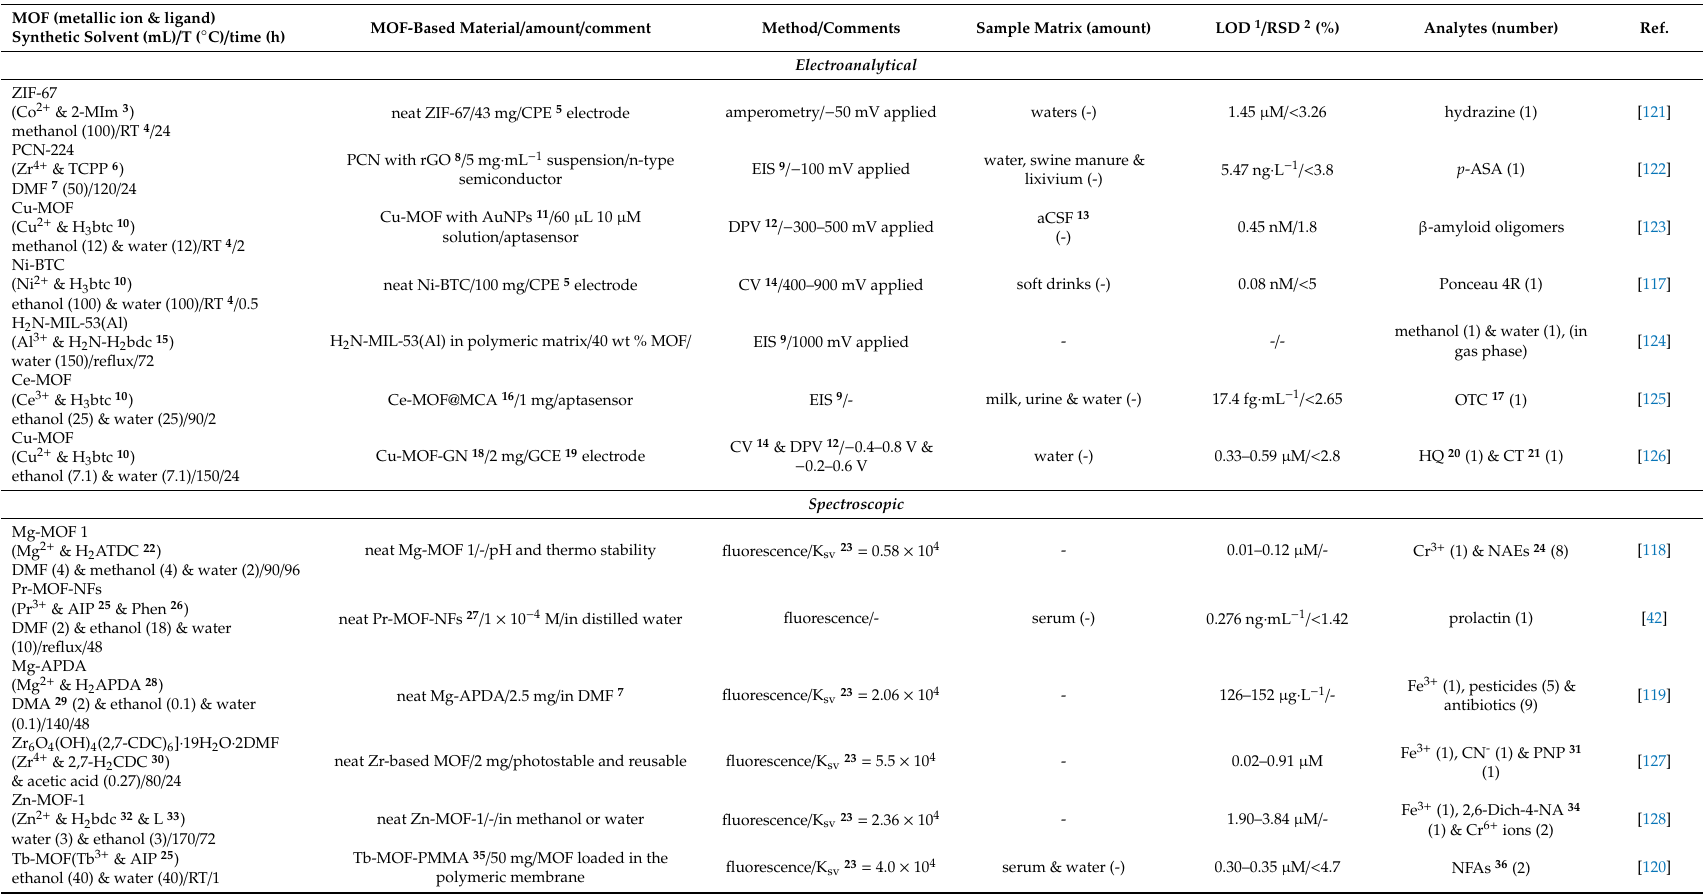
Table 4. Representative examples of electroanalytical and spectroscopic applications incorporating MOFs in the period